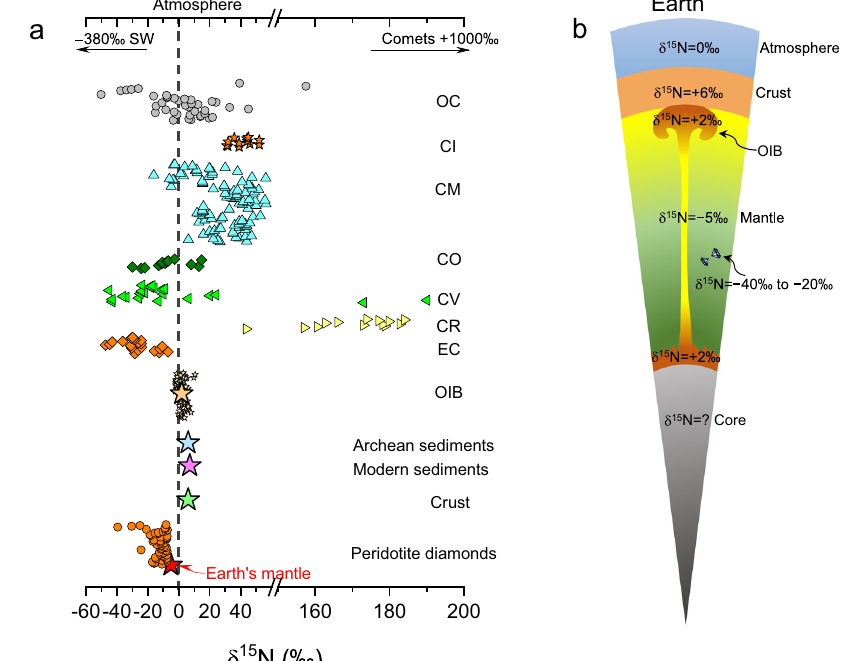
Fig. 1 | The N-isotopic composition ( δ 15 N) of cosmochemical and geochemical reservoirs.a , b Earth ’ smantle δ 15 N,inferredfrom fi brousdiamondsandmid-ocean ridgebasalts,convergestowardsagloballyuniformvalueof − 5 ‰ ;however,insome mantleperidotitediamonds,the δ 15 Nareaslowas − 40 ‰ ,whicharecomparableto EC δ 15 N.ThepositiveOIB δ 15 NareregardedtobeprimordialfeaturesofEarth ’ sdeep